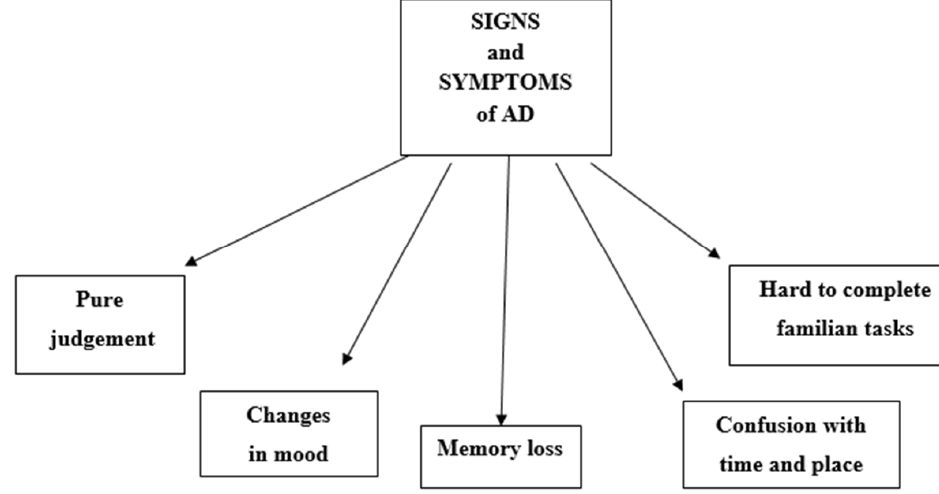
Figure 1. Early symptoms of AD.